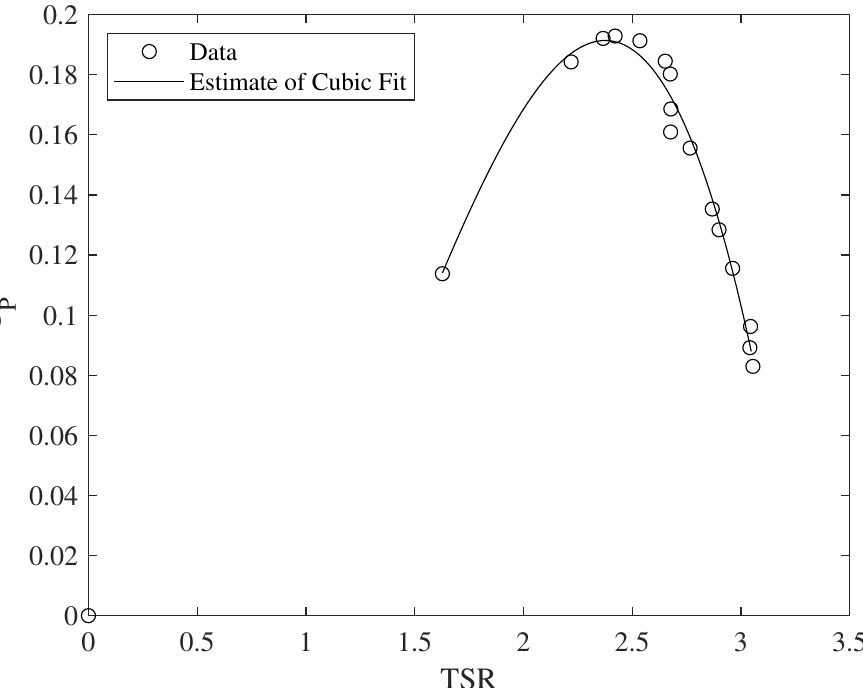
Figure 7. Power curve of one of the turbines used in this experiment and a least squares fit to a global cubic function with free end